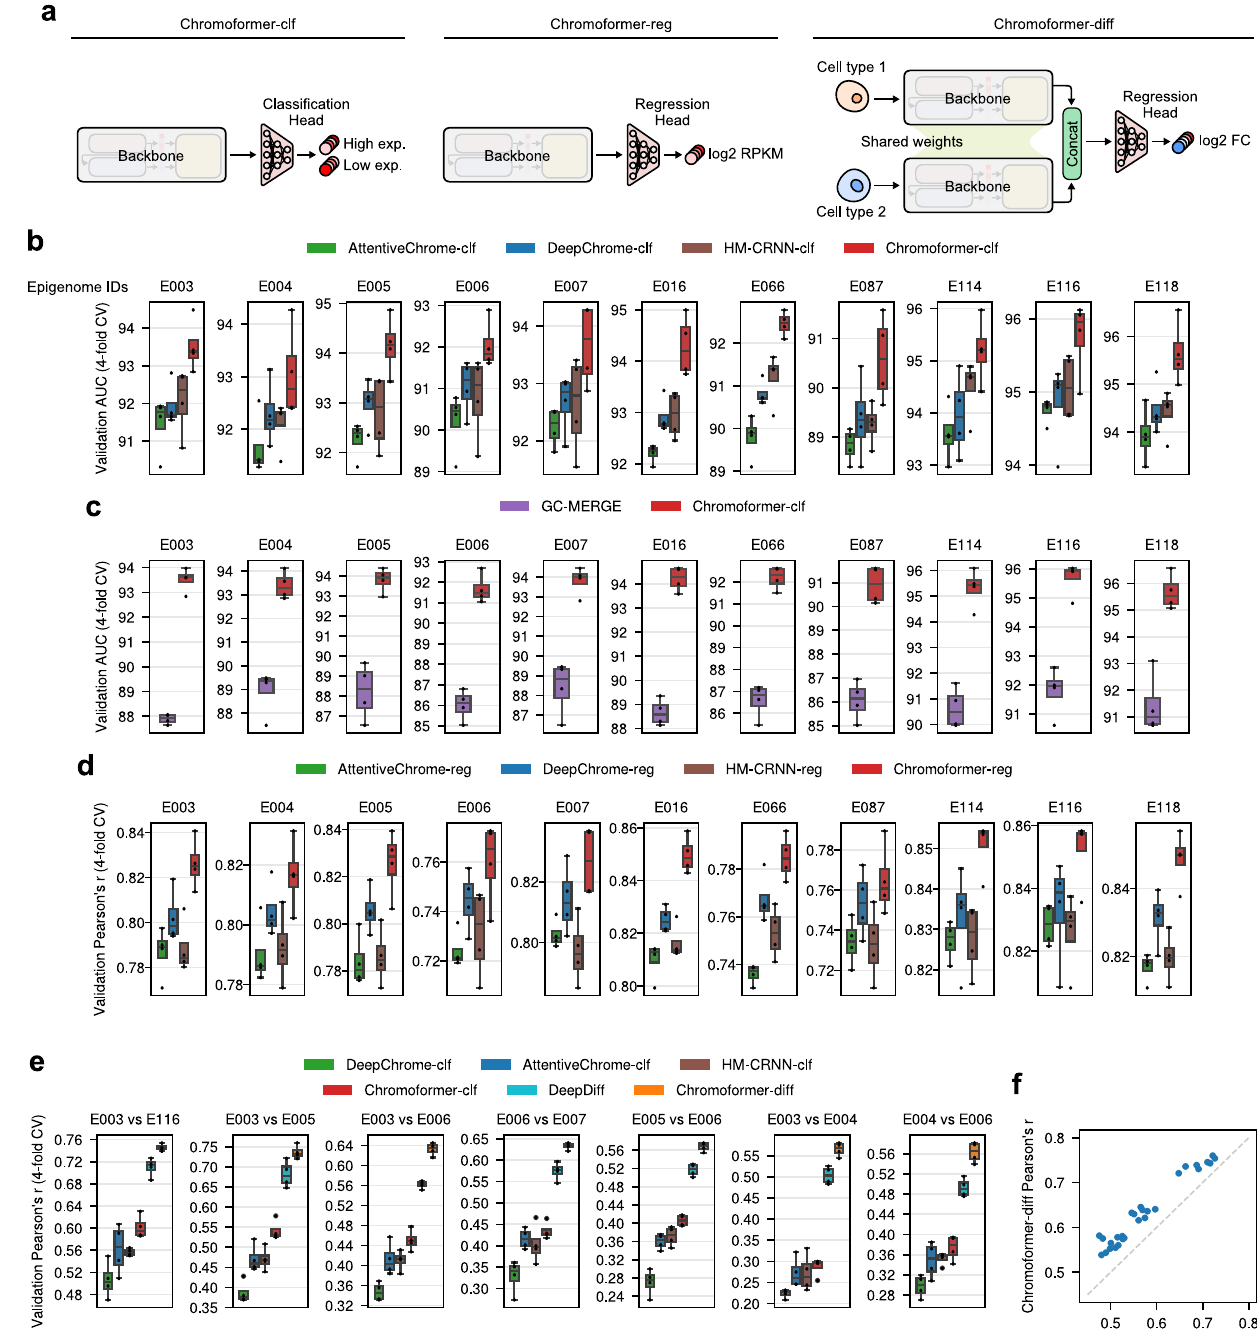
Fig. 2 | Chromoformer outperformed existing deep learning models in pre- dicting gene expression in various aspects. a Three variants of Chromoformer evaluated in this study. Chromoformer-classi fi er (Chromoformer-clf) predicts binary gene expression labels. Chromoformer-regressor (Chromoformer-reg) predictstheexpressionlevels(inlog2RPKM)ofgenes.Chromoformer-diffpredicts the log2 fold-change of gene expression given the HM con fi gurations of two dif- ferent cell types for each gene. b Cross-validation ( n =4) performances of Chromoformer-clf compared to the benchmark deep learning models that only utilize the core promoter features. c Comparison of cross-validation ( n =4) per- formances with GC-MERGE, a graph neural network model that utilizes 3D cis - regulatory interactions. For fair comparisons, Chromoformer-clf models were retrained from scratch using only a subset of genes that GC-MERGE can predict.